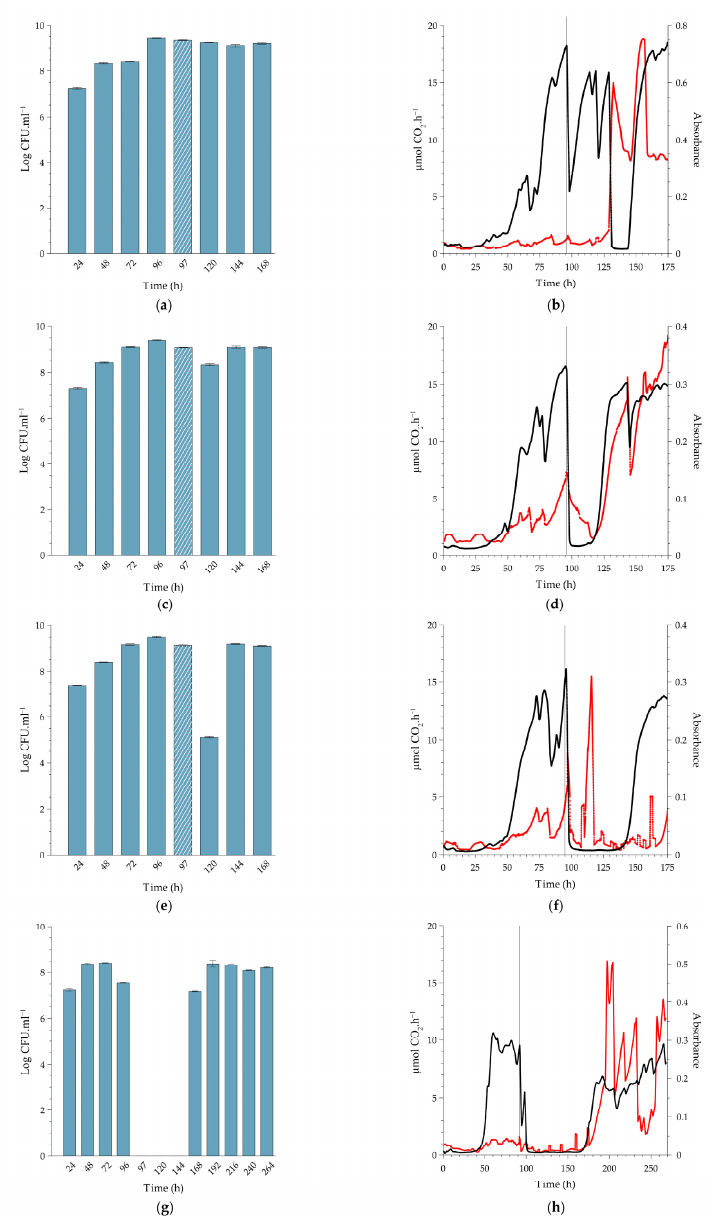
Figure 4. Biofilm growth of L. monocytogenes serovar 1 / 2 a EGD-e at 22 ◦ C, which is representative